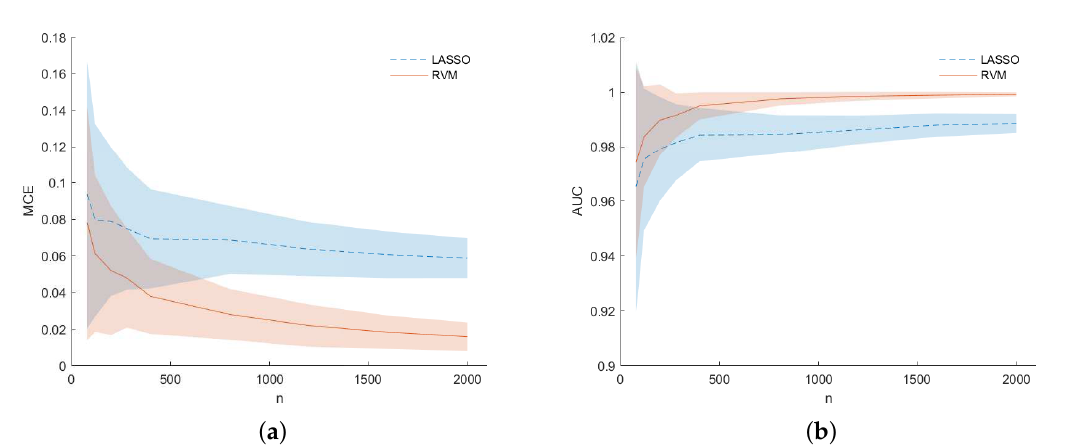
Figure 5. dataset (f): MCE ( a ) and AUC ( b ) for LASSO (dashed) and RVM (solid). The average MCE and AUC values are represented by tick lines, while the shaded areas represent the standard deviation obtained across the MC simulation.